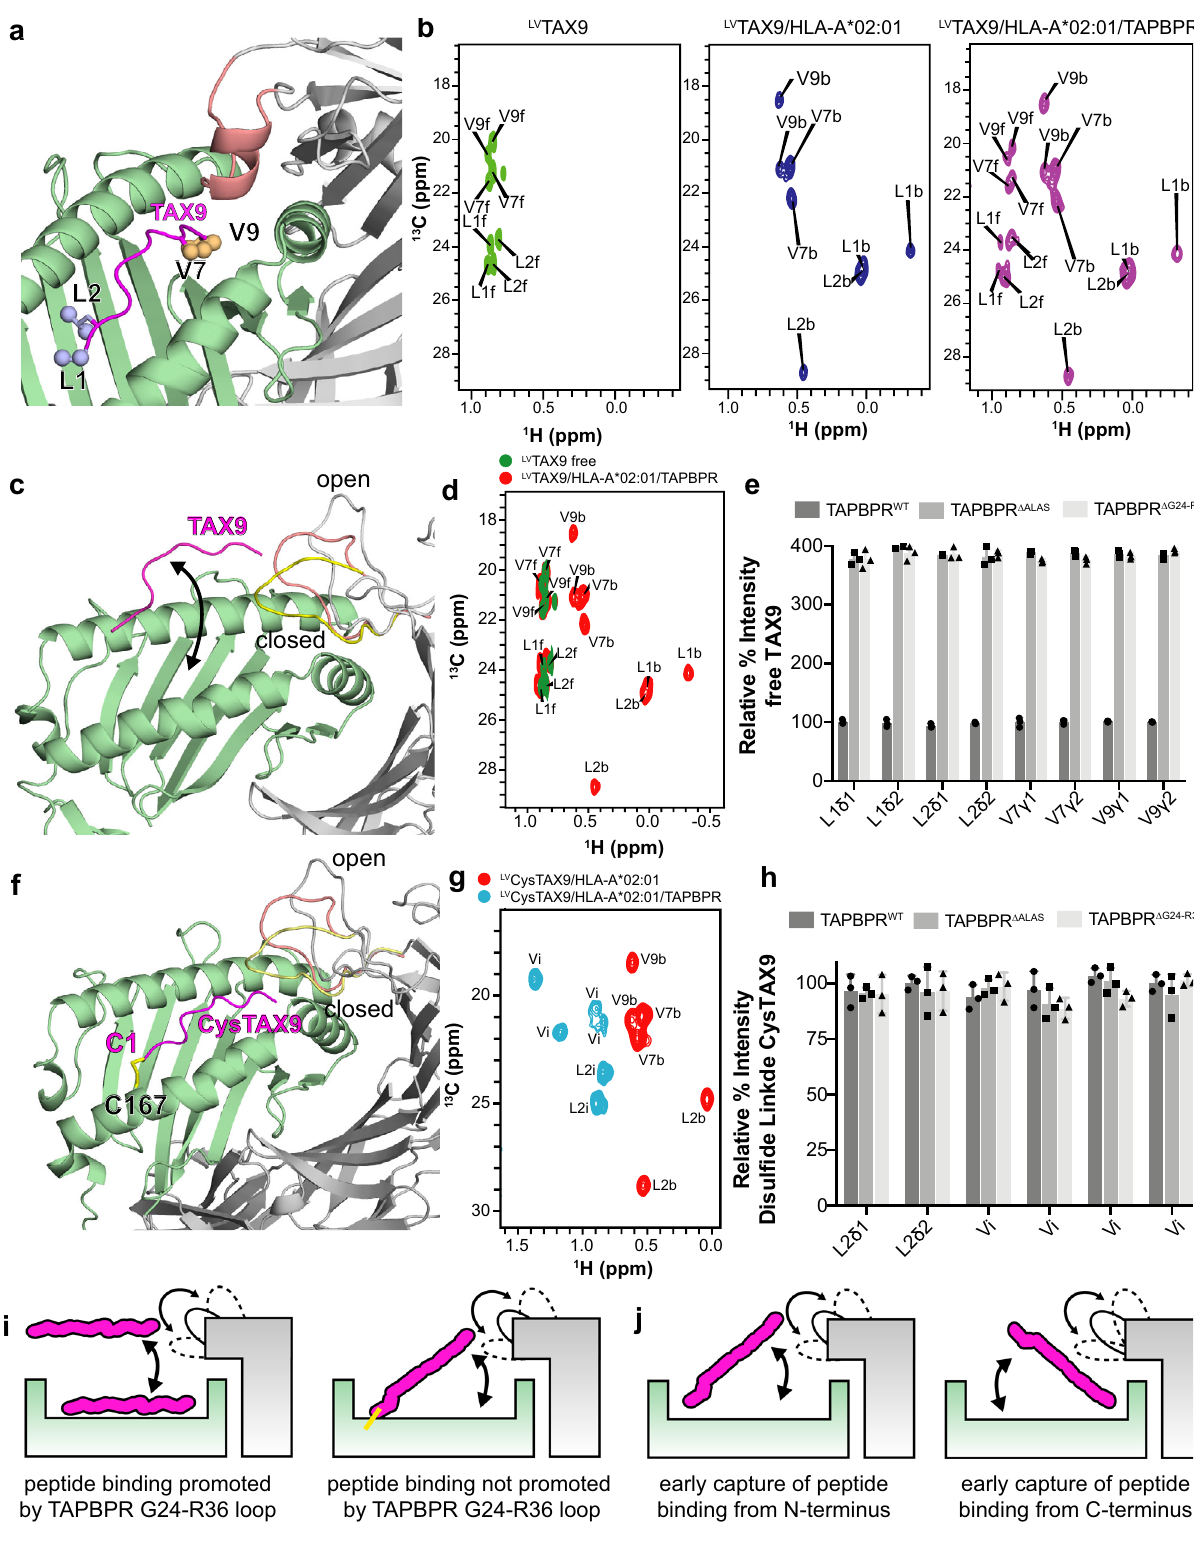
(denoted “ b ” ) (Fig. 6b). Resonances corresponding to bound peptide in the MHC-I/TAPBPR complex are broadened beyond detection, likely due to conformational exchange at the inter- mediate ( μ s-ms) timescale. To examine the effects on the TAPBPR G24-R36 loop on exchange, we developed an in vitro